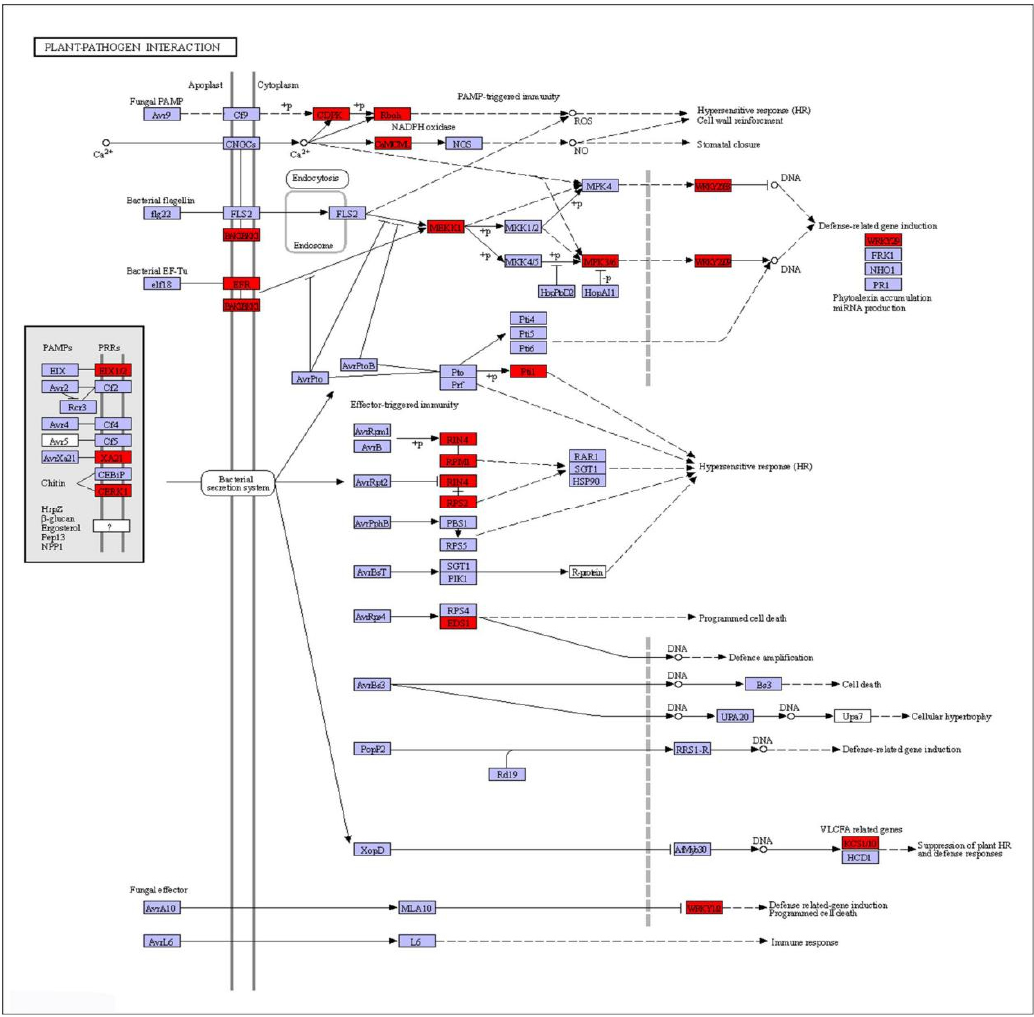
Figure 8. The photosynthesis pathways and expression profile of DEGs in GGZ001. The red color represents the upregulated DEGs.